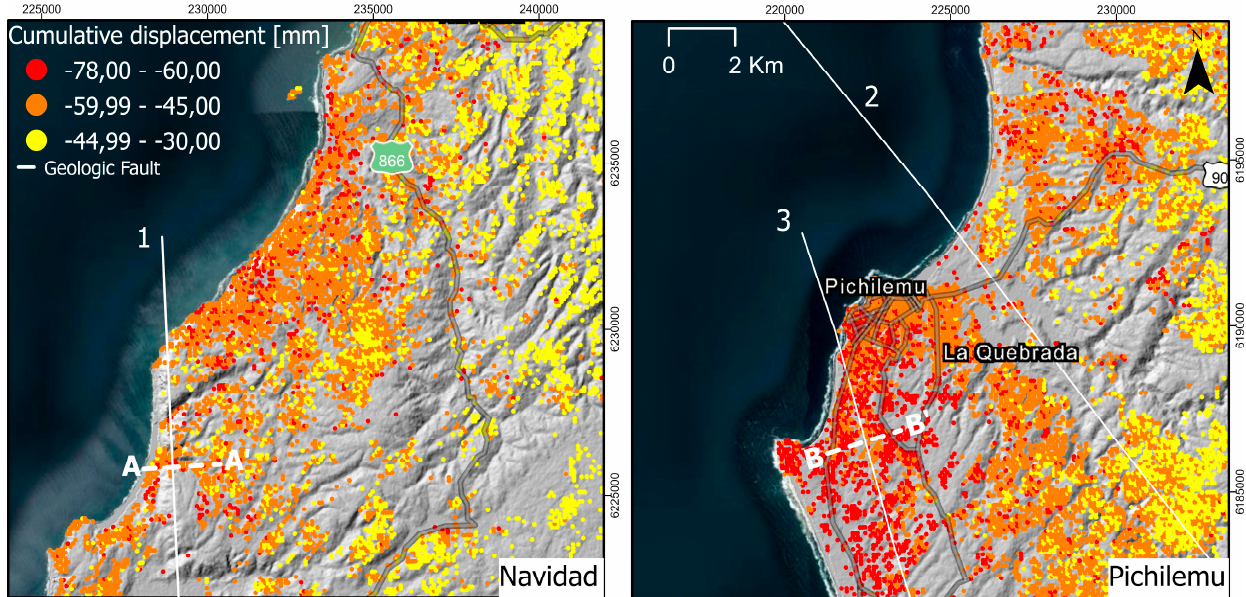
Figure 13. Cumulative displacement maps [mm] for Navidad and Pichilemu; white lines represent geologic faults crossing coastal zone of Navidad and urban area of Pichilemu; background DEM ALOS PalSAR 12.5 mts.